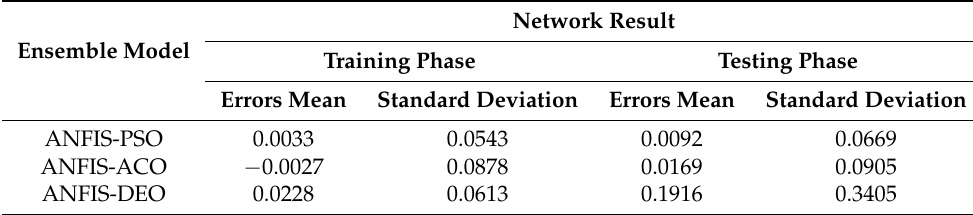
Table 11. The calculated errors of the implemented